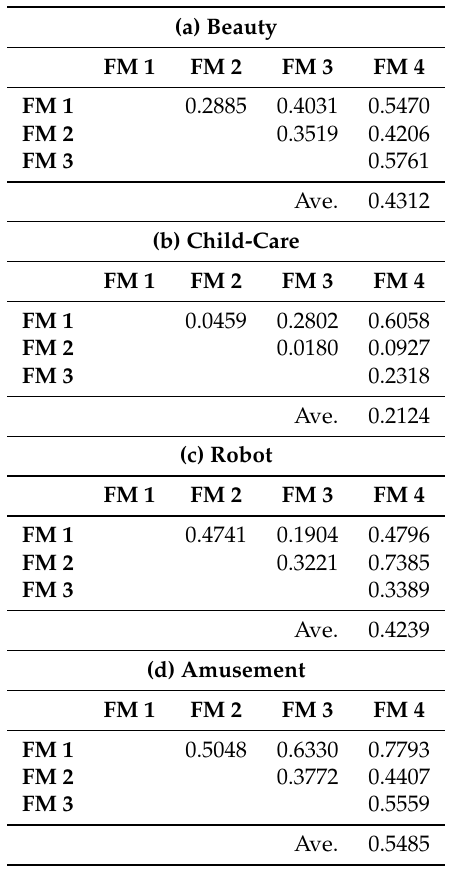
Table 1. Cohen’s κ for two-category task among four experienced fund